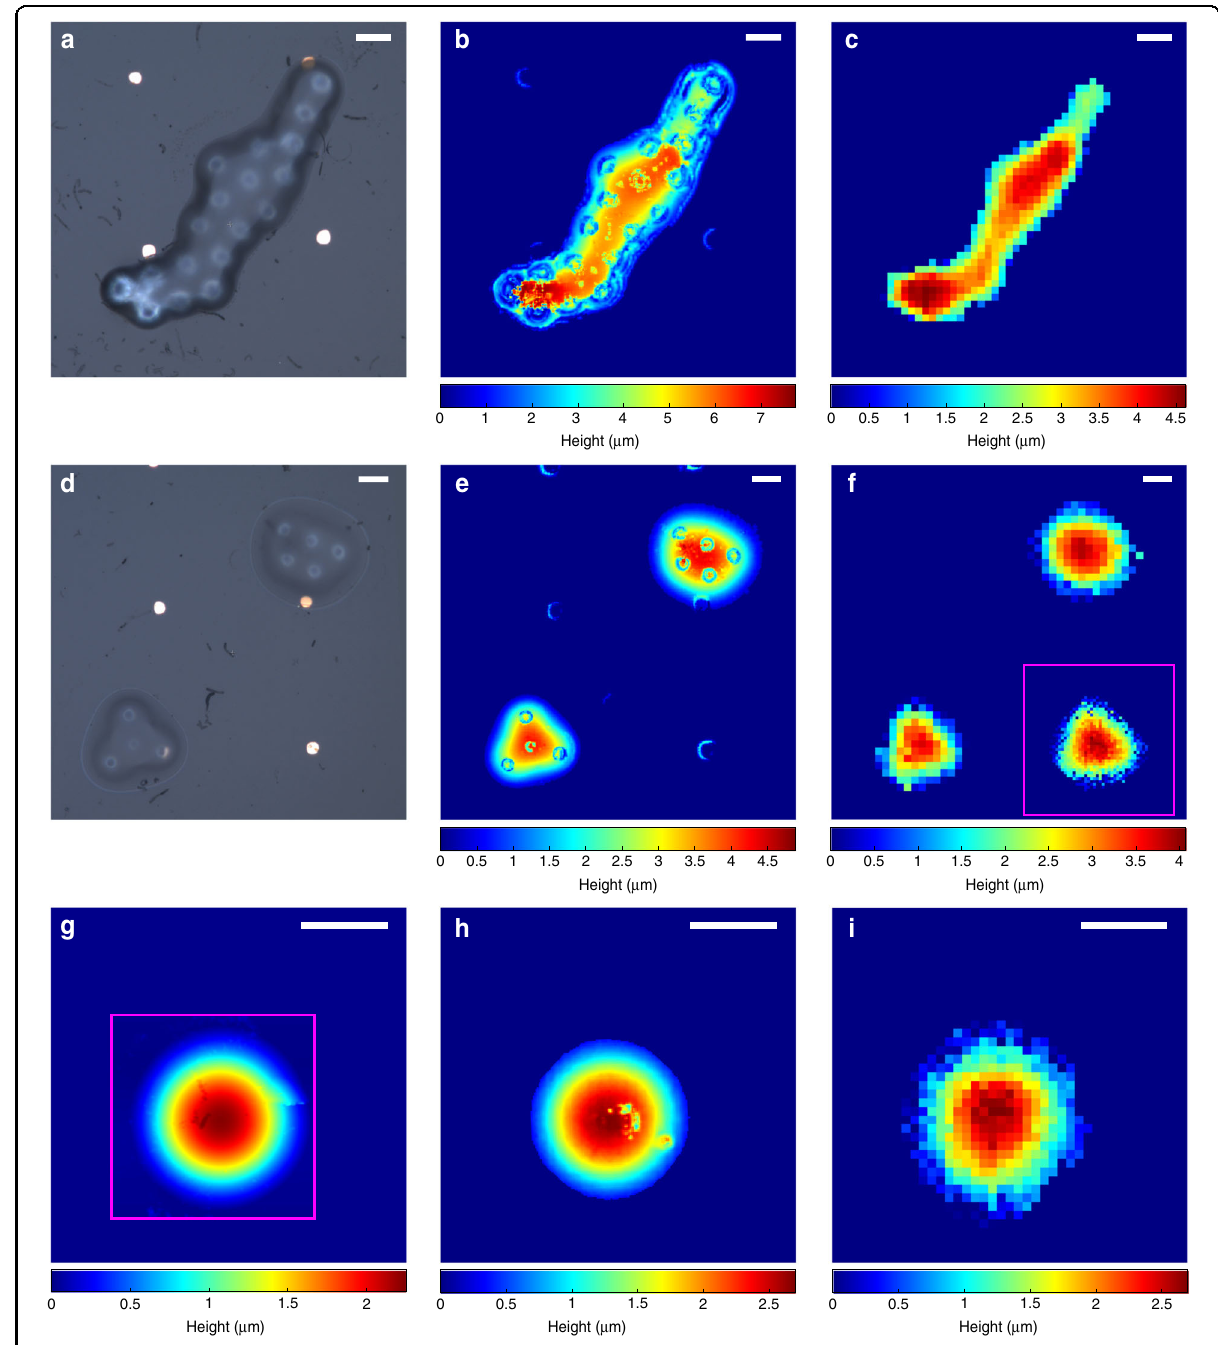
Fig. 4 3D picosecond ultrasonic pro fi lometry of microscopic objects. a , d Optical bright fi eld images of the scanned PS microstructures. b , e , h Optical pro fi lometry reveals the full height of the microstructures, yet contains artefacts due to the optical inhomogeneity of the objects. c , f , i 3D height reconstruction using the phonon probe for picosecond ultrasonic pro fi lometry. Relative height measurements were achieved for c , f and a full height reconstruction was possible for i . f Pink square reveals bottom left object with fi ner spatial sampling. g Pro fi le measured through AFM, with insuf fi cient depth-measurement range to recover the object peak; pink square indicates the AFM fi eld of view. Scale bars are 10 μ = 2.695 μ m, which demonstrates good instance was h performed on this particular object, as shown in Fig. 4g. pup agreement with the optical pro fi lometry measurement of Despite the AFM having insuf fi cient depth-measurement = 2.700 μ m. Atomic force microscopy (AFM) was also h range to corroborate the measurements from the optical abs